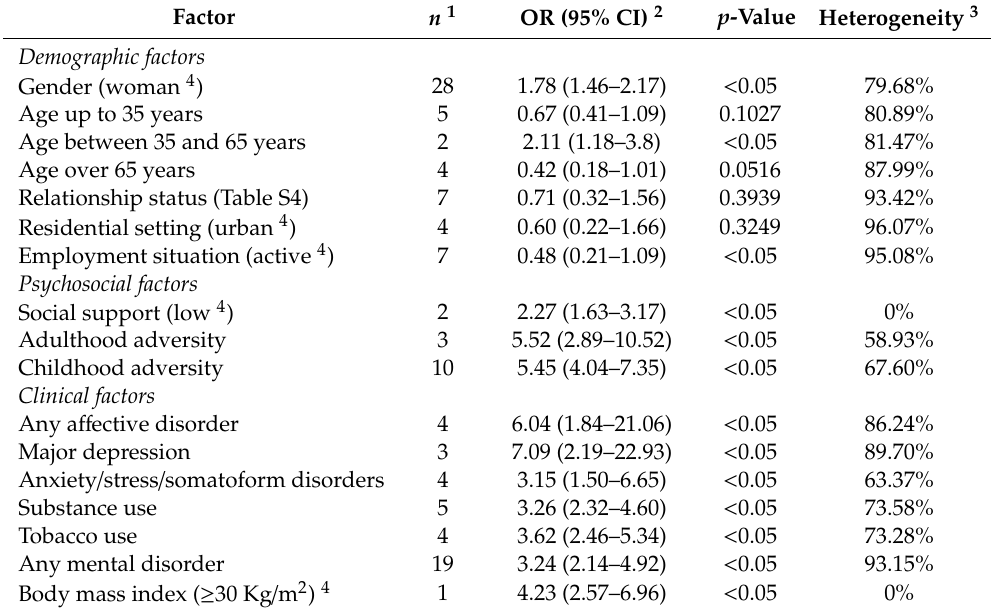
Table 4. Calculated odds ratio for suicidal attempts considering all time